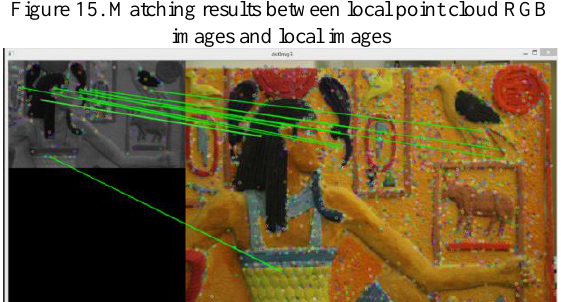
Figure 16. Matching result between local point cloud reflection intensity image and local image 5.